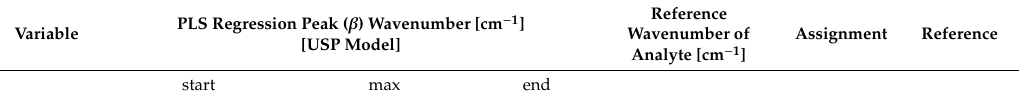
Table 2. The dominant PLS regression peaks of glucose, lactate, VCD, and antibody and their corresponding Raman spectroscopy vibrational signatures based on previous literature values detailing reference wavenumbers for variables of